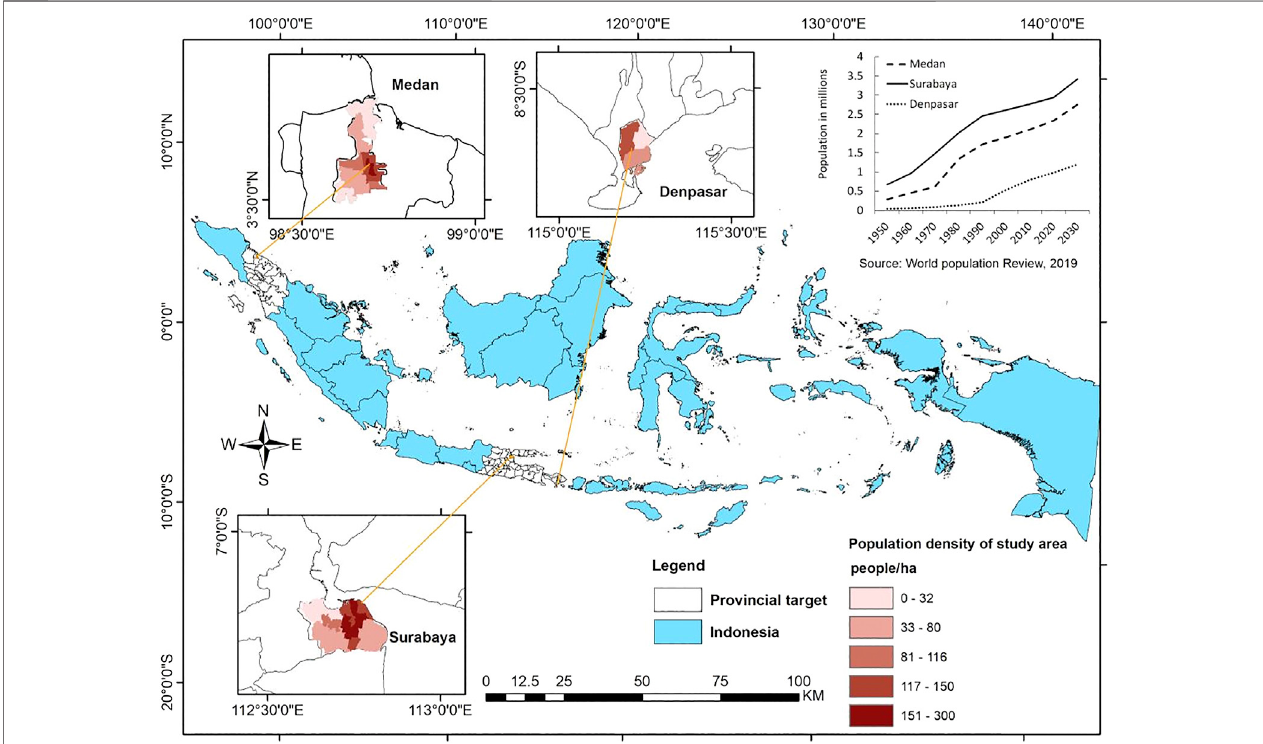
FIGURE 1 | Locations of the selected study areas in the Republic of Indonesia.